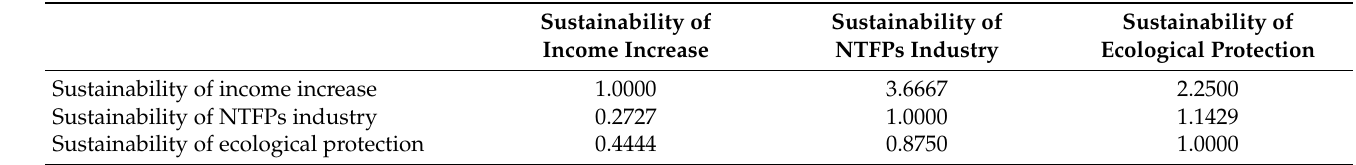
Table A3. B2–C: Judgement matrix of the sustainability of poverty alleviation.